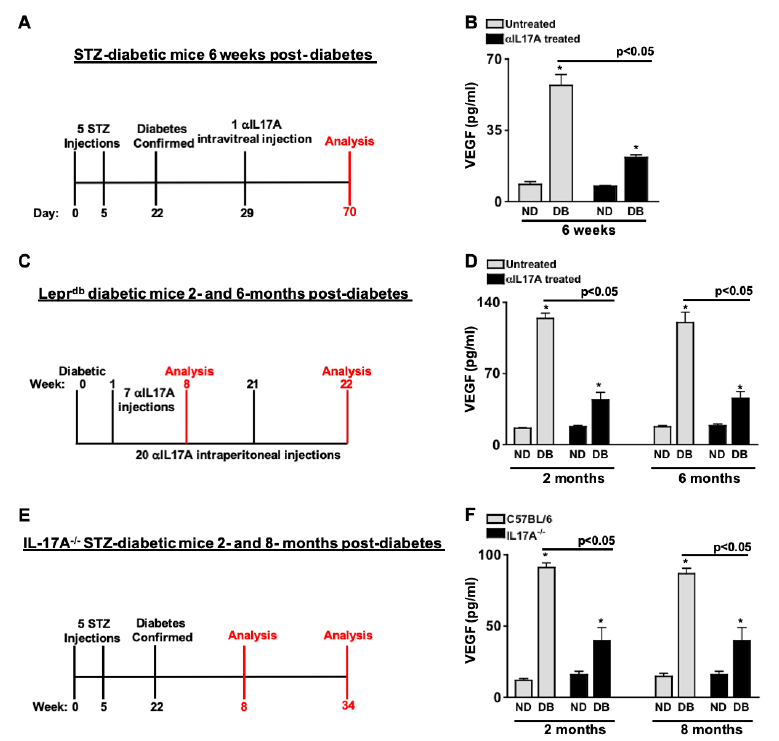
Figure 1 . Inhibition of Diabetes-Mediated IL-17A Decreases VEGF Production. ( A ) Schematic of the 6-week analysis of STZ-diabetic C57BL/6 mice (n = 9/group) receiving an anti-IL-17A intravitreal injection. ( B ) Quantification of VEGF in retinas of untreated (grey) and anti-IL-17A treated (black) non-diabetic (ND) and diabetic (DB) mice 6 weeks post-diabetes. ( C ) Schematic of the 2- and 6- month analyses of Lepr db mice (n = 9/group) receiving weekly intraperitoneal injections of anti-IL- 17A. ( D ) Levels of VEGF in the retinas of untreated (grey) and anti-IL-17A treated (black) non-dia- betic (ND) and diabetic (DB) Lepr db mice 2- and 6-months post-diabetes. ( E ) Schematic of the 2- and 8-month analyses of STZ-diabetic C57BL/6 and IL17A -/- mice (n = 9/group). ( F ) Quantification of VEGF in the retinas of C57BL/6 (grey) or IL17A -/- (black) non-diabetic (ND) and diabetic (DB) mice 2- and 8-months post-diabetes. Error bars represent the SEM; * p < 0.01. The p -value was first equated by two-way ANOVA analysis and then unpaired S tudent’s t - test with Tukey’s post -hoc analysis. 2.3. IL-17A Induces VEGF Production in Retina Cells Previously, we reported that Muller glia and retinal endothelial cells express the IL- 17A receptor [6]. To determine if IL-17A can induce these retina cells to produce VEGF, cells were stimulated with 20 ng/mL of rIL-17A for 16 h, and levels of VEGF in spent me- dia were quantified by ELISA. As shown in Figure 2, only negligible levels of VEGF were detected in all of the unstimulated (unstm-grey) cells. Mouse Muller glia (mMG) pro- duced ~57 pg/mL (Figure 2A), human Muller glia (hMG) produced ~78 pg/mL (Figure 2B), mouse retina endothelial cells (mREC) produced ~48 pg/mL (Figure 2C), and human ret- ina endothelial cells (hREC) produced ~37 pg/mL (Figure 2D) of VEGF when they were stimulated with recombinant (r)IL-17A (IL-17A stm-black). Taken together, IL-17A can induce these retina cells to produce VEGF.